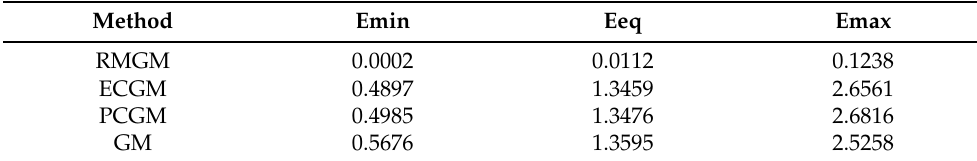
Table 6. Composite position error.